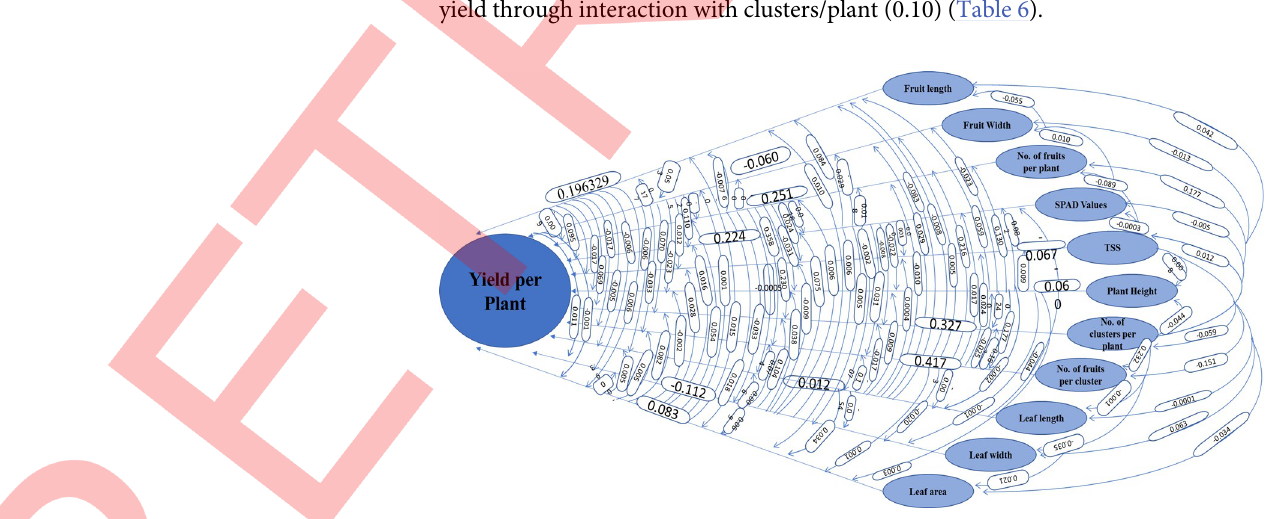
traits, followed by SPAD values and fruit width. Heritability values of different traits ranged from 79.77 to 95.01% (Table 5). Usually, the traits that have higher heritability and genetic diversity are preferred for any breeding program. Higher heritability among traits indicated less influence of environmental factors on the genotypes. The highest genotypic correlation of yield was observed with the number of fruits per plant (0.83) (Table 5). (Table 6, Fig 1). The number of fruits/cluster had a maximum value (0.42) and the positive direct effect on the yield. Number of fruits/cluster also had indirect effects on yield by affecting the number of clusters per plant (0.18) and fruits/plant (0.21). As number of fruits/cluster has both direct and indirect effects on yield, therefore the genotypic correlation between number of fruits/cluster and yield (0.80) was eventually increased. The chlorophyll contents also had direct positive effects (0.22) on yield. The yield of the plants is directly and positively affected due to the length and width of fruits. The leaf surface area’s width also indirectly affected the yield through interaction with clusters/plant (0.10) (Table 6).